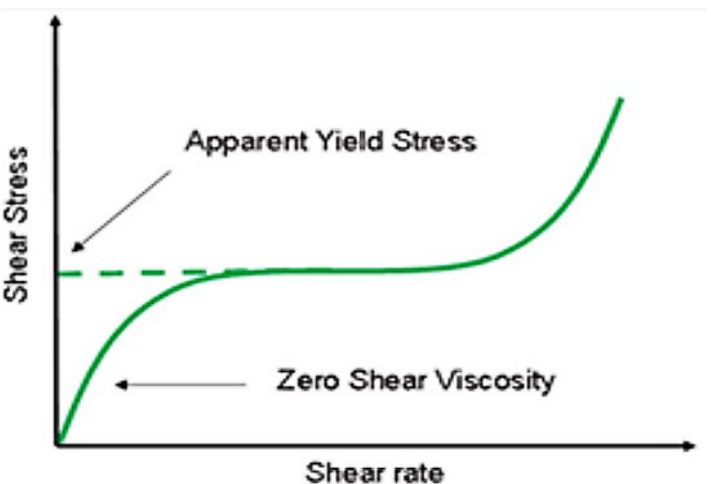
Table 1. Regression functions for viscosity change with a varying shear rate of different viscoelas- tic type1 fluids at Temperature 25